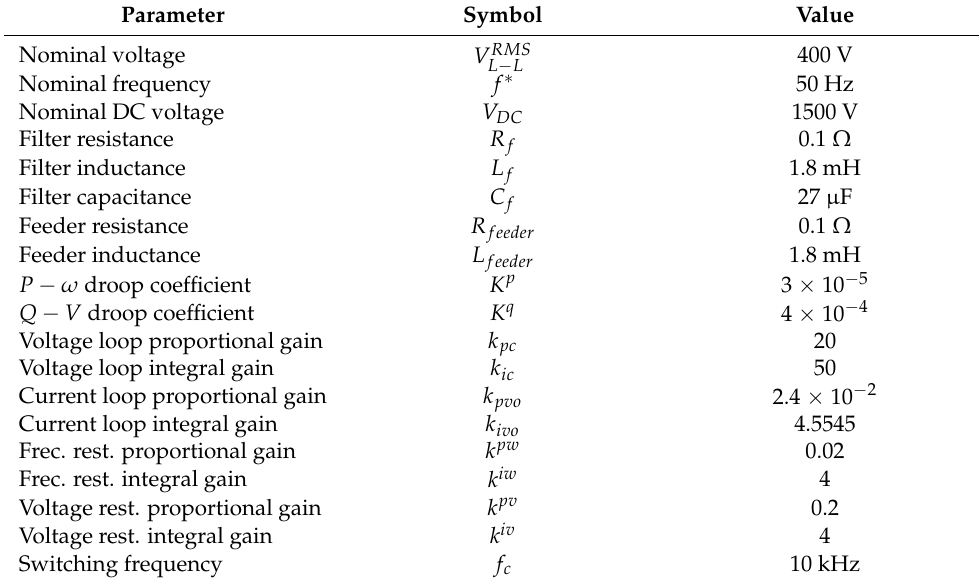
Table 1. Parameters of the case study microgrid and